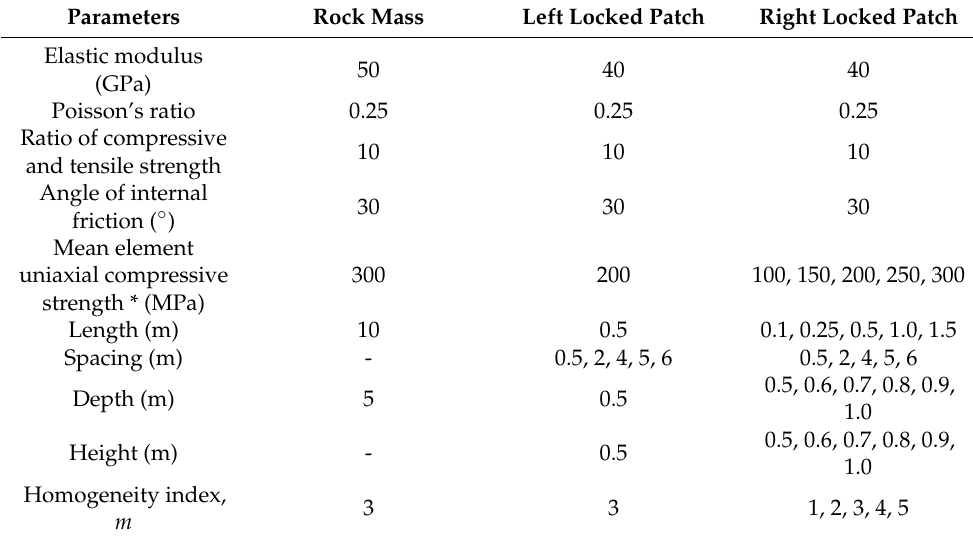
Figure 2. Illustration of the numerical model. Table 1. Input parameters for numerical modelling.